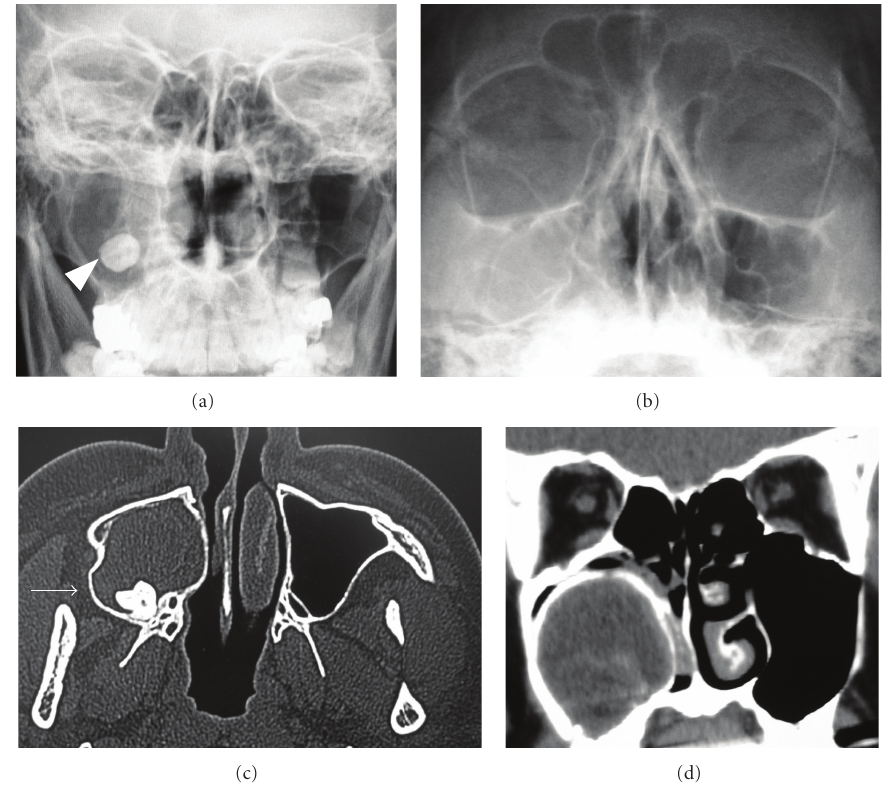
Figure 1: (a) X-ray shows cloudy appearance in the right maxillary sinus including an impacted tooth (arrowhead) in the Caldwell view. (b) X-ray shows cloudy appearance in the right maxillary sinus in the Waters view. (c) Axial view of the CT scan shows a cystic lesion expanding the lateral wall (arrow) of the maxillary sinus containing the impacted tooth inside. (d) Coronal view of the CT scan shows the calcificated cystic wall.